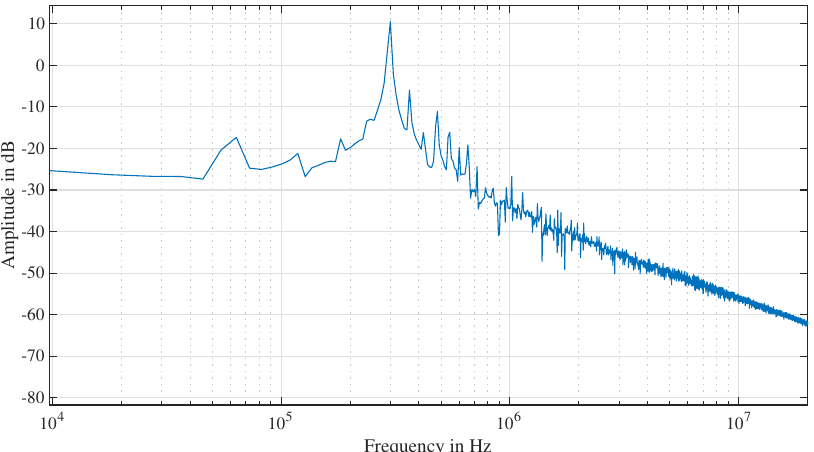
Figure 12. Fast Fourier transformation of the signal at node B ( V B ) during 200 µ s of the on-state of the Colpitts oscillator generated from the simulated